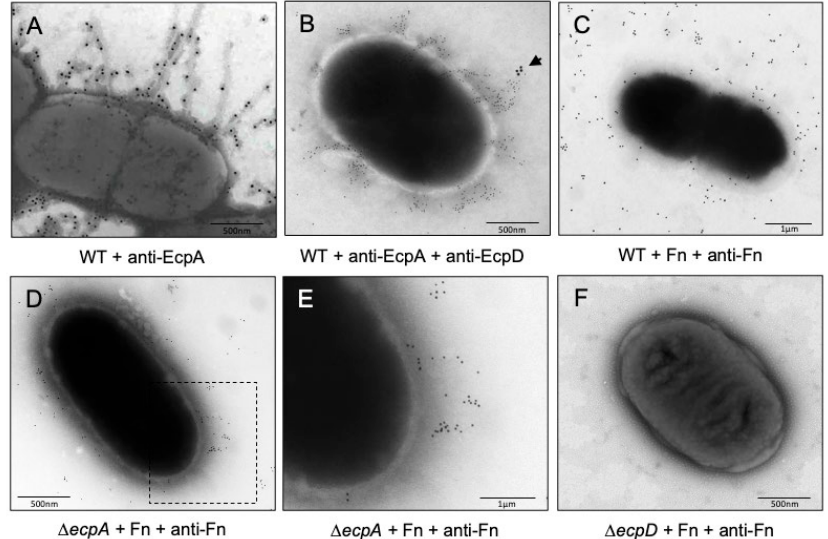
Figure 3. Binding of Fn to EPEC. Negative staining and immunogold labeling of E2348/69 showing production of EcpA fibers ( A , B ) and tip adhesin EcpD ( B ). ( C ) Binding of Fn to the wild-type strain E2348/69 using anti-Fn antibodies. ( D , E ) Binding of Fn to the ∆ ecpA mutant using anti-Fn antibodies. Panel E is a magnification of the squared area shown in panel D. Note the immunostaining pattern is compatible with the reported fibrillae structure of EcpD. ( F ) No gold was present in the ∆ ecpD mutant, which indicates no Fn binding. Arrow points to EcpD.